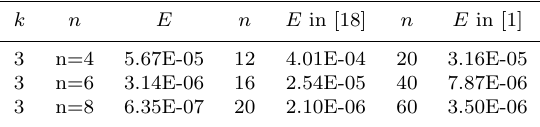
Table 1. Maximum absolute error for Example 1